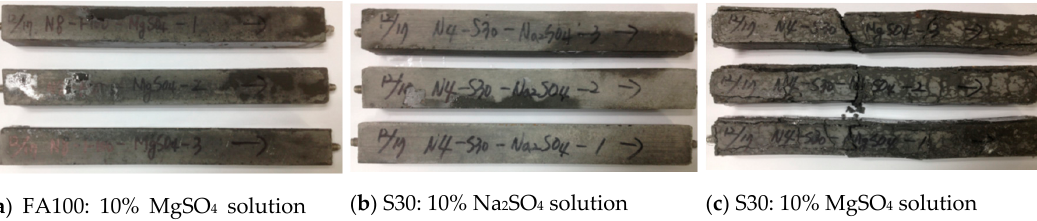
Figure 8. Mortar specimens according to sulfate solution type; ( a ) FA100 samples immersed in 10% MgSO 4 solution, ( b ) S30 samples immersed in 10% Na 2 SO 4 solution, and ( c ) S30 samples immersed in 10% MgSO 4 solution.